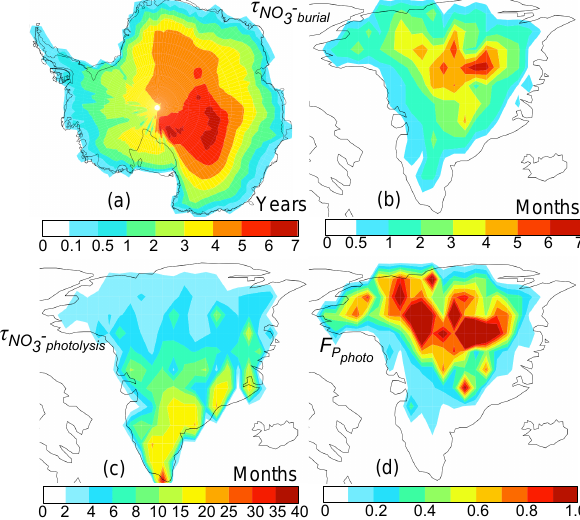
compared to without F NO . x x